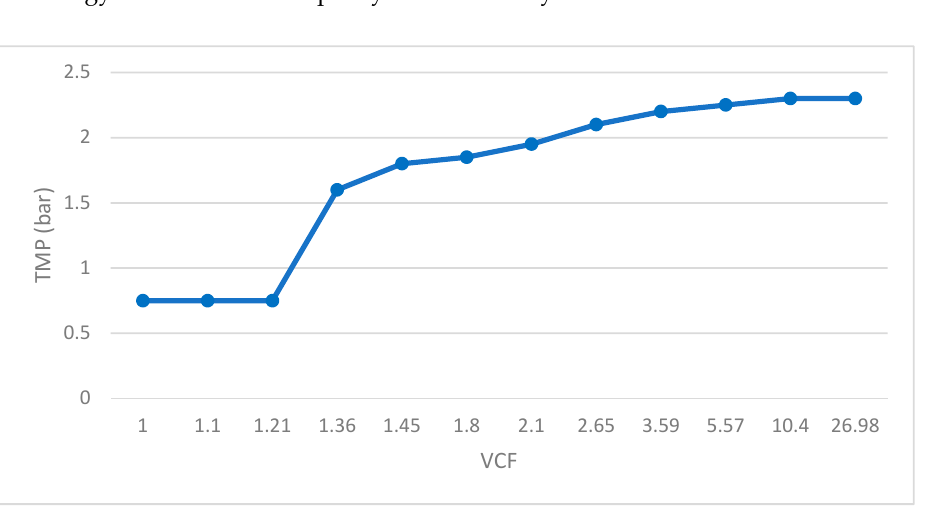
Figure 7. Changes in TMP related to variations of VCF during ultrafiltration test development.